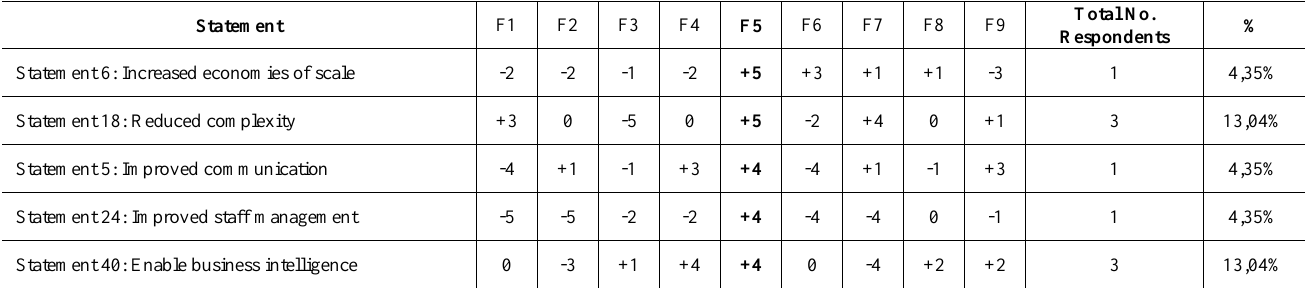
Table 9: Factor 5. Simplicity valuer, key